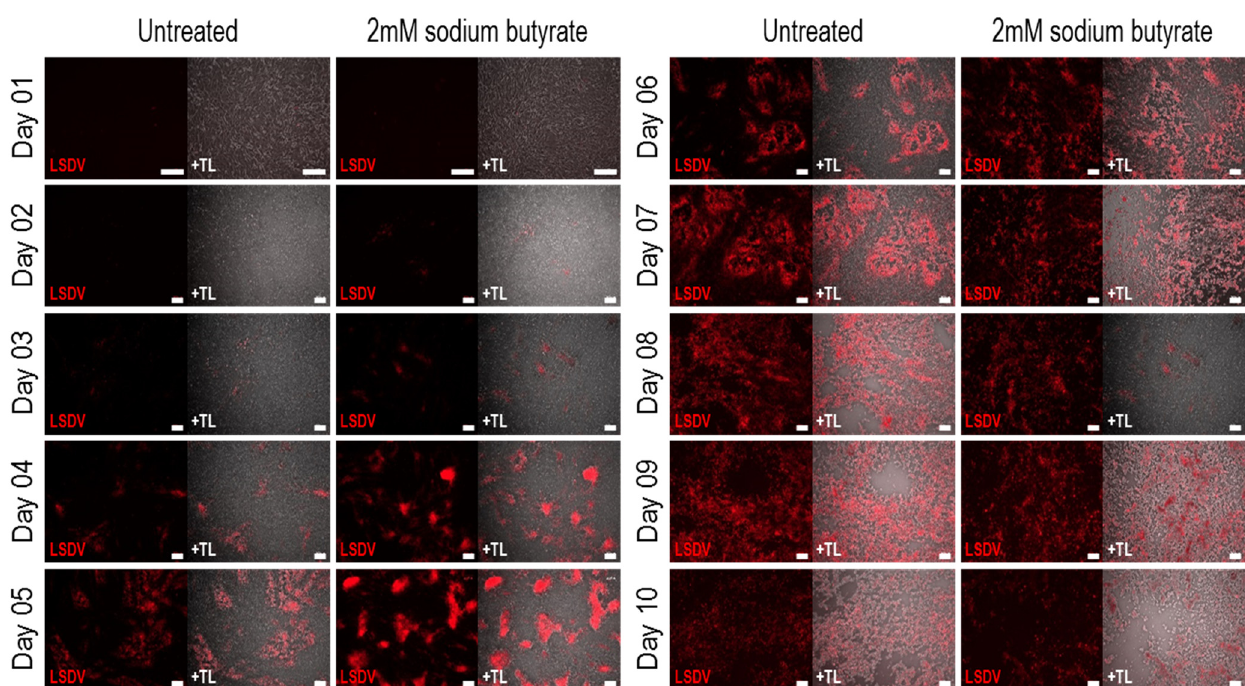
Figure 3. Growth of LSDVGC5 (expressing mCherry) in BHK-21 cells with and without sodium butyrate. Cells were infected on day 0 at MOI = 0.5. Scale bar = 200 µ m.